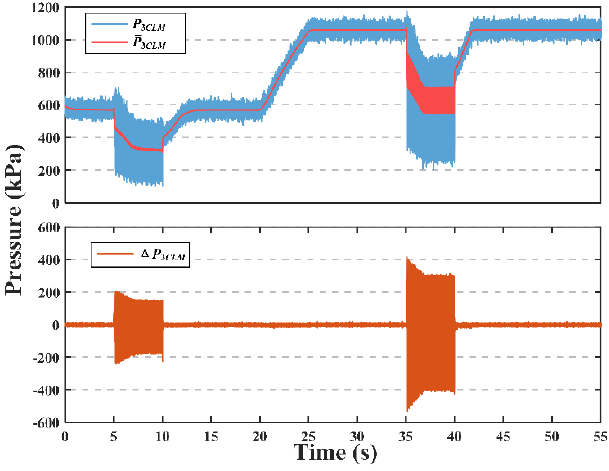
Figure 15. The steady-state pressure component 𝑃(cid:4636) (cid:2871)(cid:3004)(cid:3013)(cid:3014) and the the pulsating pressure component Δ 𝑃 (cid:2871)(cid:3004)(cid:3013)(cid:3014) of simulated pressure 𝑃 (cid:2871)(cid:3004)(cid:3013)(cid:3014) . ∆ P 3 CLM of simulated pressure P 3 CLM .